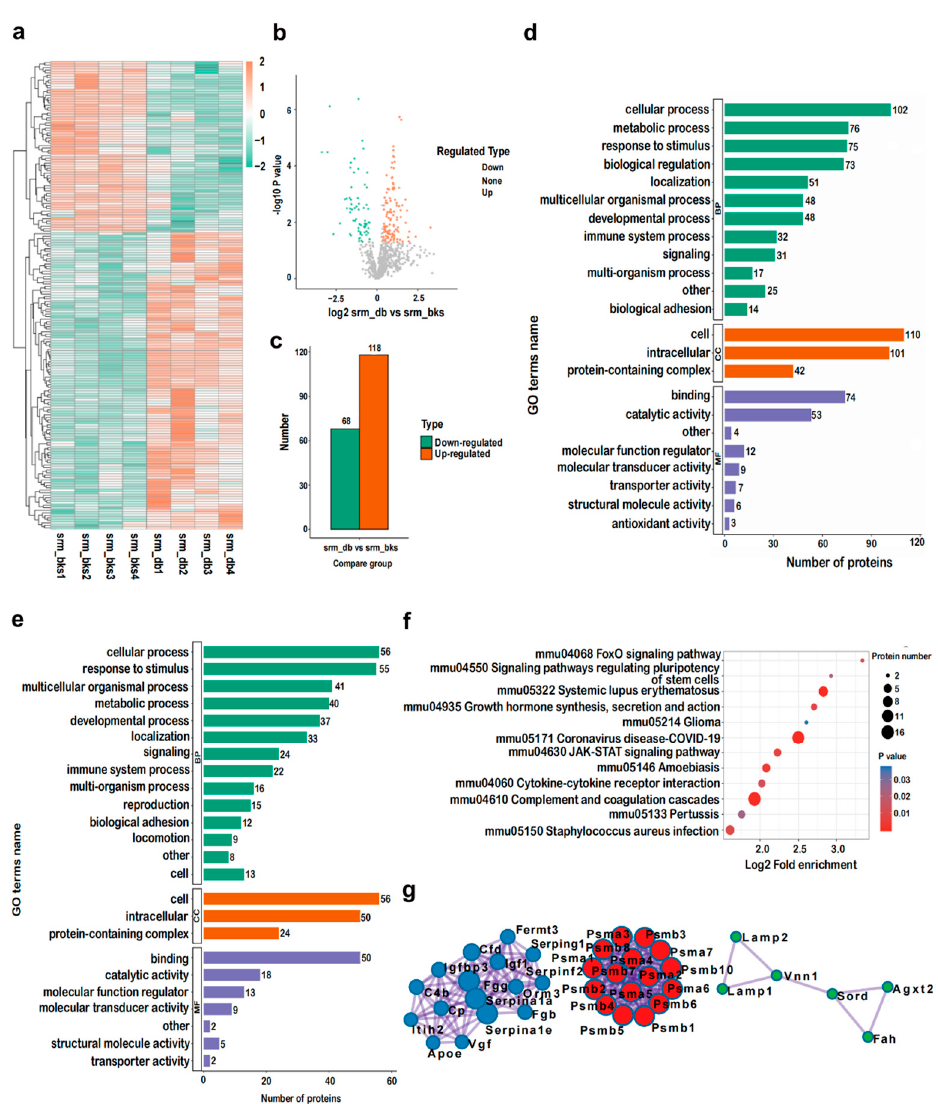
Figure 3. Identification and bioinformatics analysis of serum DEPs in db / db mice compared with the bks mice. ( a ) Heatmap, ( b ) volcano, and ( c ) histogram showing the distribution of serum DEPs in db / db mice compared with bks mice. GO (BP) analysis of ( d ) upregulated proteins and ( e ) downregulated serum proteins in db / db mice compared with bks mice. ( f ) KEGG pathway analysis of downregulated DEPs in the mouse serum. ( g ) PPI network of the optimized upregulated and downregulated DEPs in the mouse serum. Table 1. The list of clustered serum DEPs identified by MCODE.